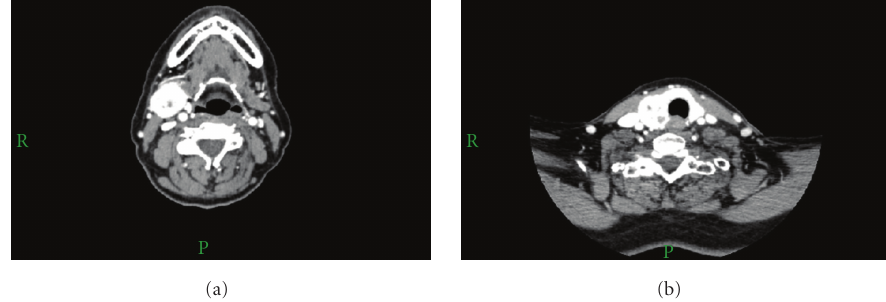
Figure 1: CT of neck with contrast. (a) Well-defined tumour mass in the right submandibular gland measuring 29 × 26 × 30 mm. It shows prominent vascularisation which would be unusual for benign lesion such as PA. There is some low-density area centrally in the tumour probably related to necrosis. (b) There is a large nodule in the thyroid on the right side measuring 26 × 23 × 30mm showing similar intense enhancement as the submandibular lesion.